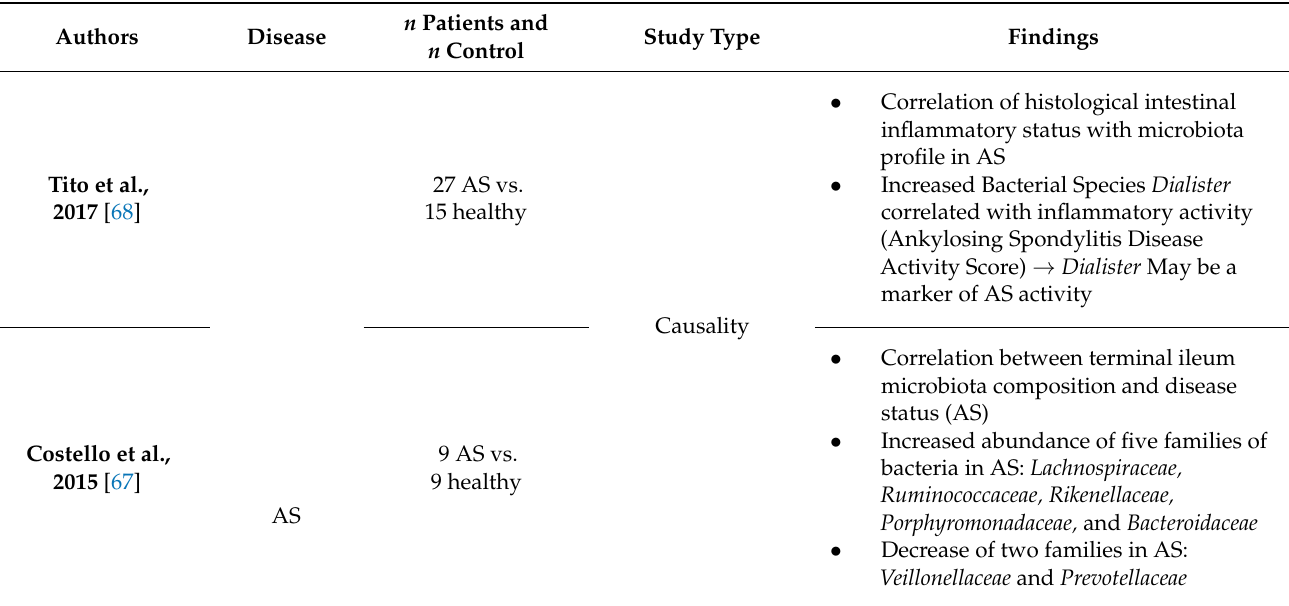
Table 3. Clinical studies in other autoimmune diseases (not